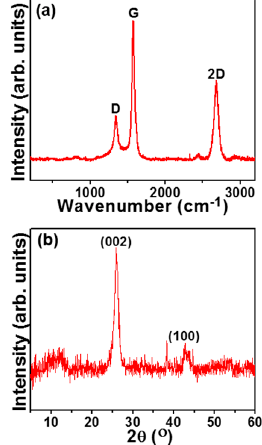
Figure 3. ( a ) Raman ( λ = 532 nm) spectrum and ( b ) X-ray diffraction spectrum of the LIGNs.